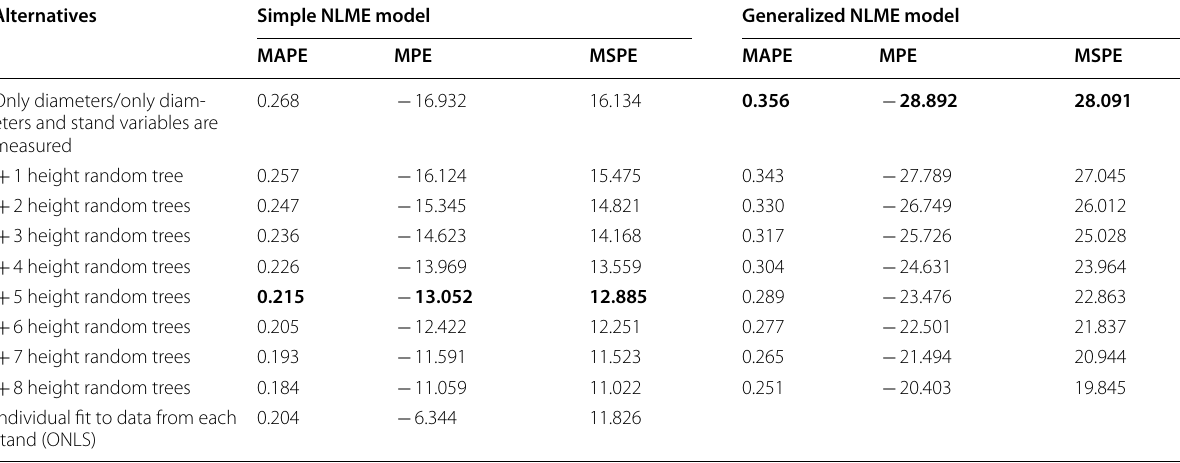
Individual fit to data from each stand (ONLS)